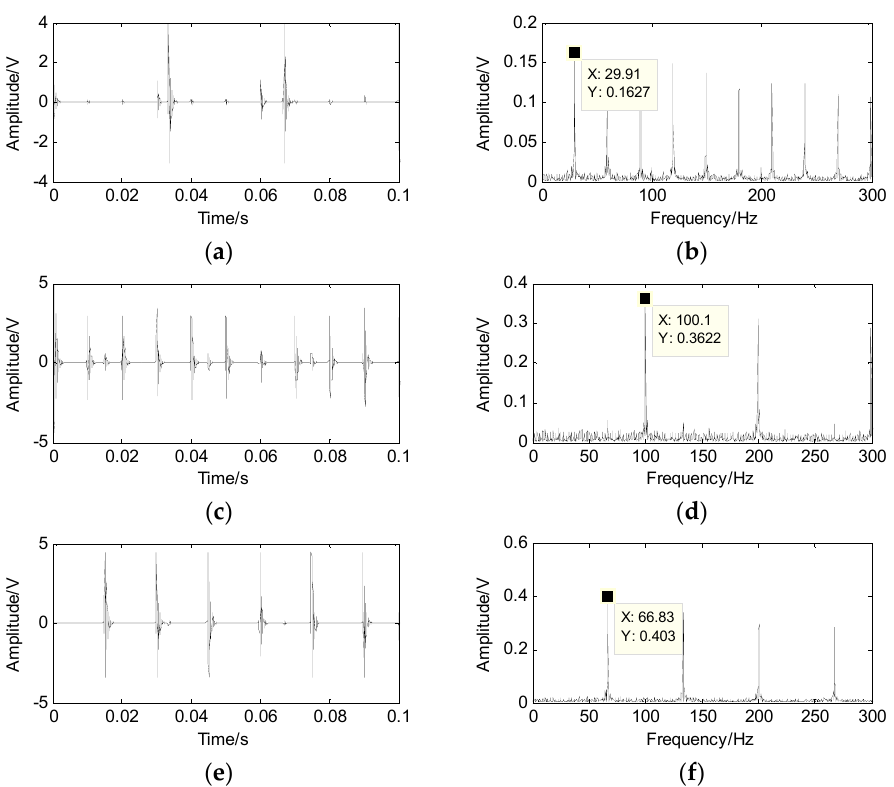
Figure 6. The separation of the simulated signals and their spectra. ( a ) the first separation of signal; ( b ) the spectrum of the first separation; ( c ) the second separation of signal; ( d ) the spectrum of the second separation; ( e ) the third separation of signal; ( f ) the spectrum of the third separation.